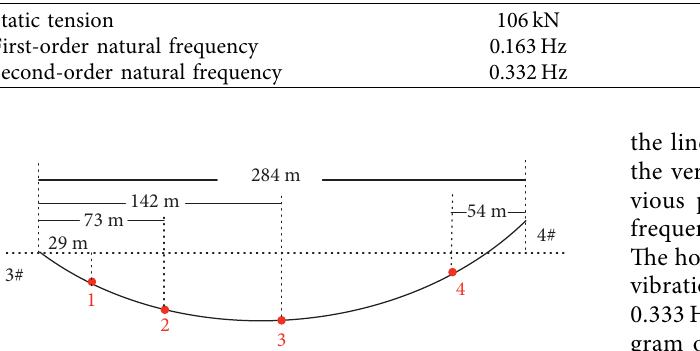
Figure 6: Location illustration of the monitoring